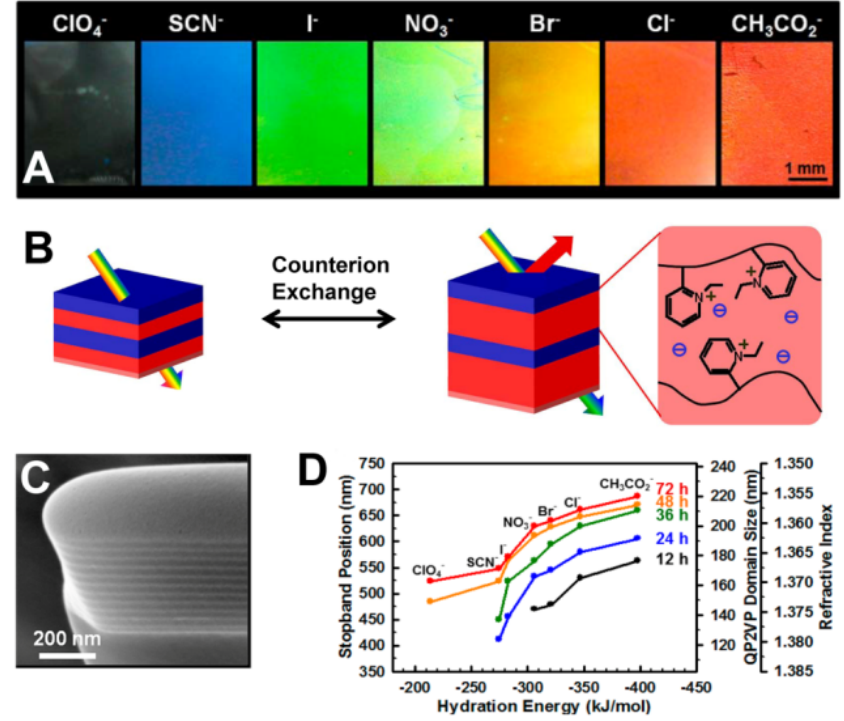
Figure 9. ( A ) Color change of the photonic gel films quaternized with direct exchange of counteranions. The color of the photonic gel films shifts from transparent to blue, green, and red as hydration energy of the counteranions increases. Reflective spectra and photographs of periodically ordered interconnecting porous gels. ( B ) Schematic representation of the mechanism for color change in the PS-b-QP2VP photonic lamellar gels via direct exchange of counterions. Depending on the hydration characteristics of the counteranions, the selective swelling in the block copolymer lamellar structures can be controlled, causing a change in optical properties. ( C ) Cross-sectional SEM image of a focused ion beam milled dry PS-b-QP2VP lamellar film. ( D ) Changes in the photonic stop band position, the QP2VP lamellar domain thickness, and refractive index of the tunable PS-b-QP2VP photonic gels as a function of the hydration energy of the counteranions